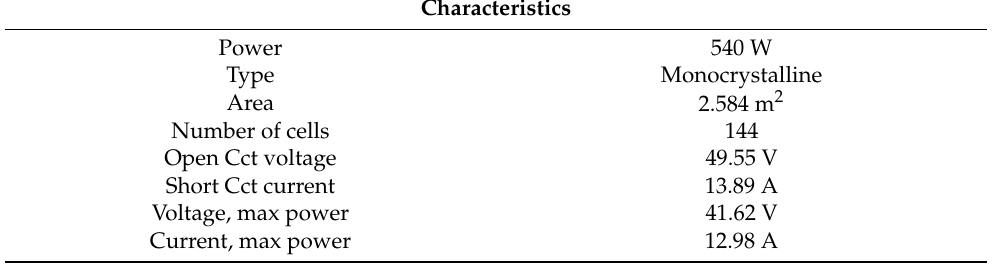
Table 3. PV catalog specifications.